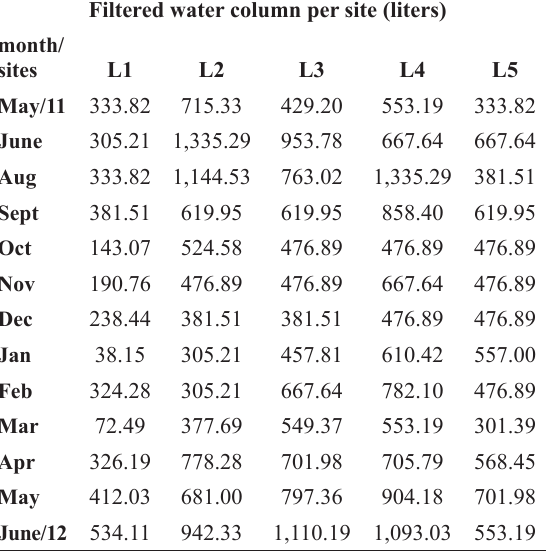
Total filtered water volume per site based on the limit of the euphotic zone. Sampled volumes for the vertical haul varied according to the size of euphotic zone. Therefore, the lengths varied from 1.62 to 15